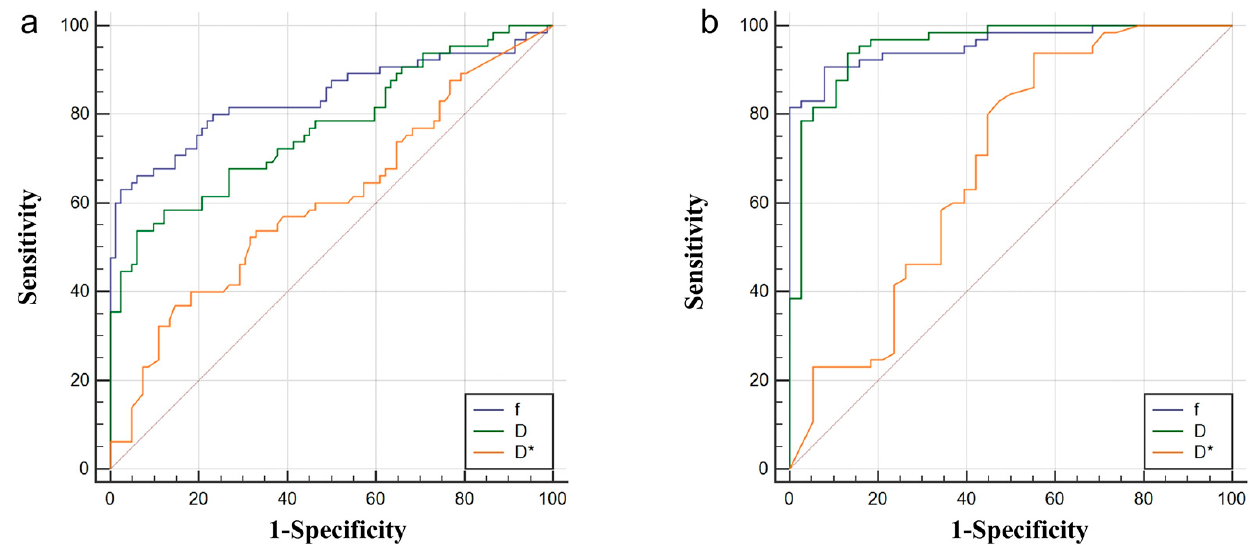
Figure 5. The f , D, and D* identify ROC curves of TAA from ANHP ( a ) and TAA from TNA ( b ). TAA: tumor active area; ANHP: adjacent normal hepatic parenchyma; TNA: tumor necrotic area. Table 5. Diagnostic capability of IVIM parameters for distinguishing different tissues. .